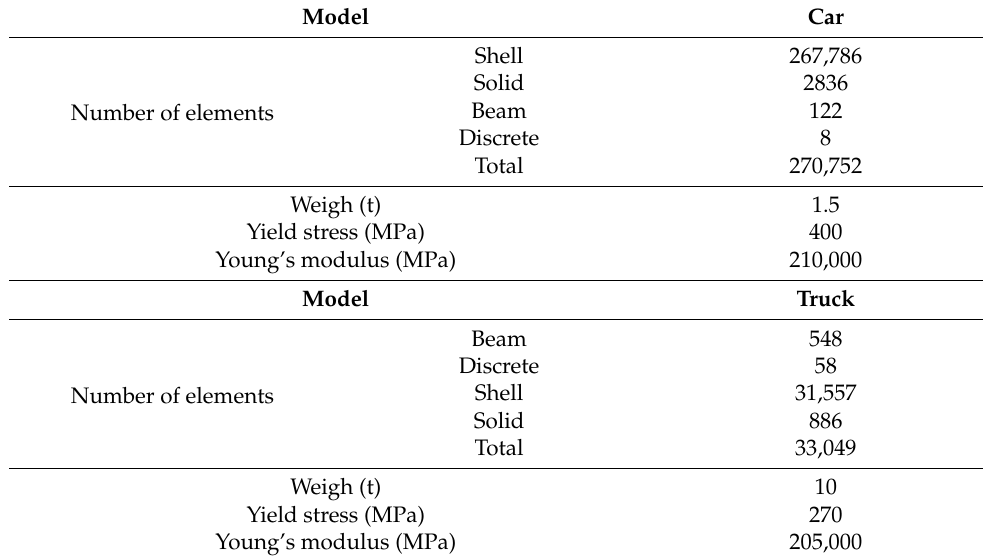
Table A6. Vehicle model data.